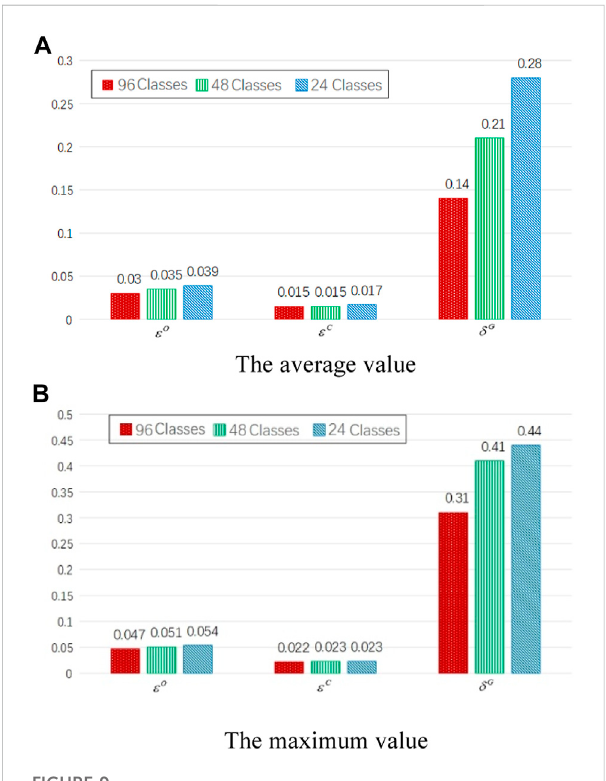
FIGURE 9 The statistics of knowledge validity indexes under different extraction depths in the distributed loads case.